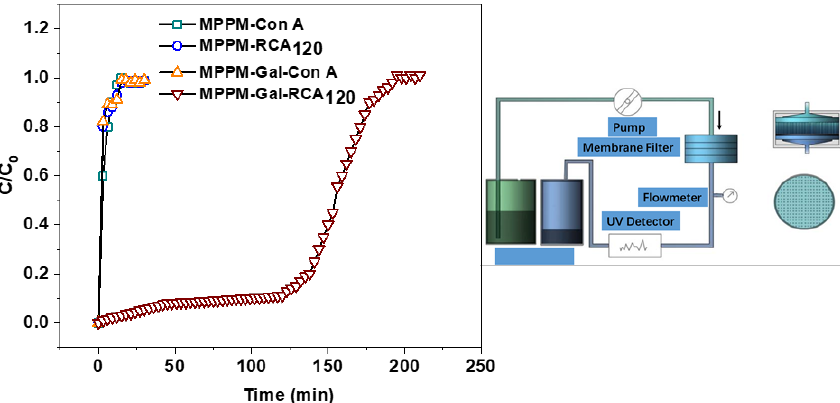
Figure 5. Breakthrough curves for lectin binding on the membranes: FITC-RCA 120 adsorbed on the pure membrane and the glycosylated membrane with glycosyl density of 5.410 nmol / cm 2 ; FITC-Con A adsorbed on the nascent membrane and the glycosylated membrane with glycosyl density of 5.410 nmol / cm 2 , respectively; filtration detection system for membrane a ffi nity adsorption (right). All experiments were repeated three times.